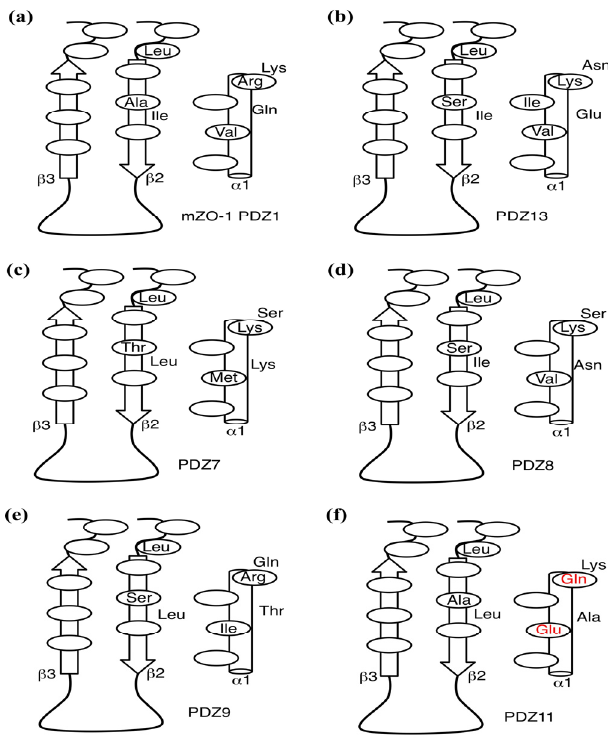
Figure 4. Comparison of the interfacial residues. Schematic of the interfacial residues of mZO-1 PDZ1 ( a ), PDZ13 ( b ), PDZ7 ( c ), PDZ8 ( d ), PDZ9 ( e ), and PDZ11 ( f ) are depicted. The canonical binding pocket lies between a β -sheet composed of β 2 and β 3 strands and α 1 helix, represented as block arrows ( β 2 and β 3 strands) and a cylinder, respectively. Each ellipse represents the location of each residue. The atypical residues of PDZ11 are in